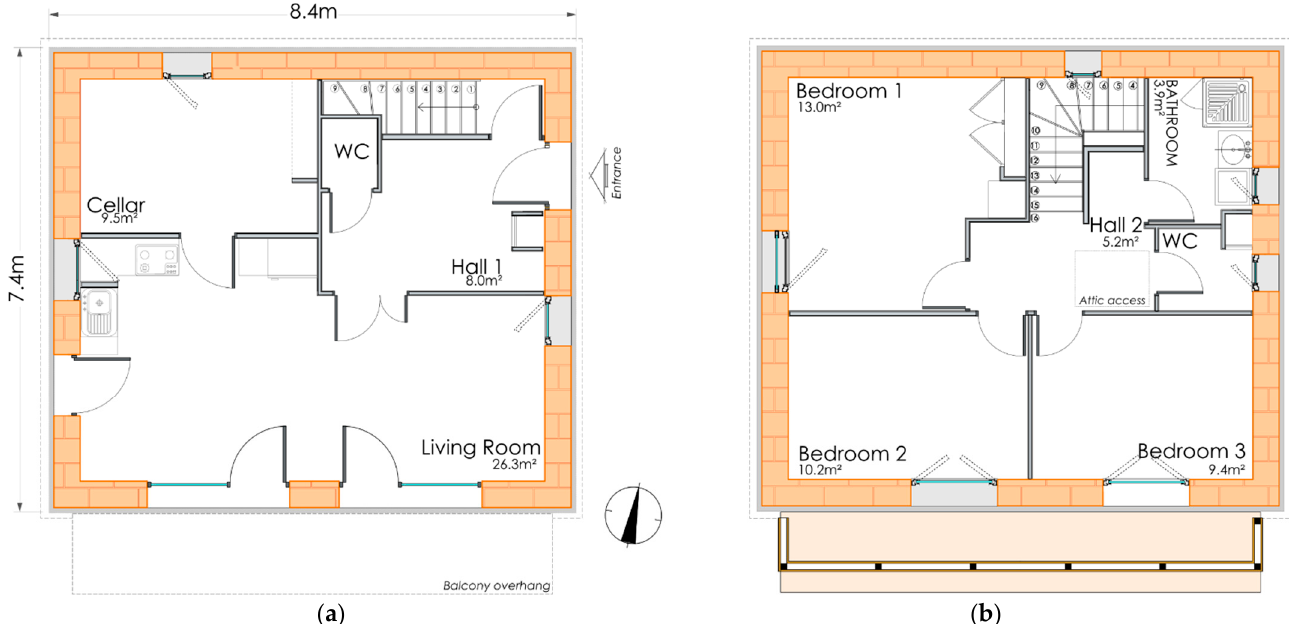
Figure A1. Visualization of the velocity vectors in the openings (integration method), for the south wind direction ( θ = 180°). ( a ), ground floor, and ( b ) first floor.